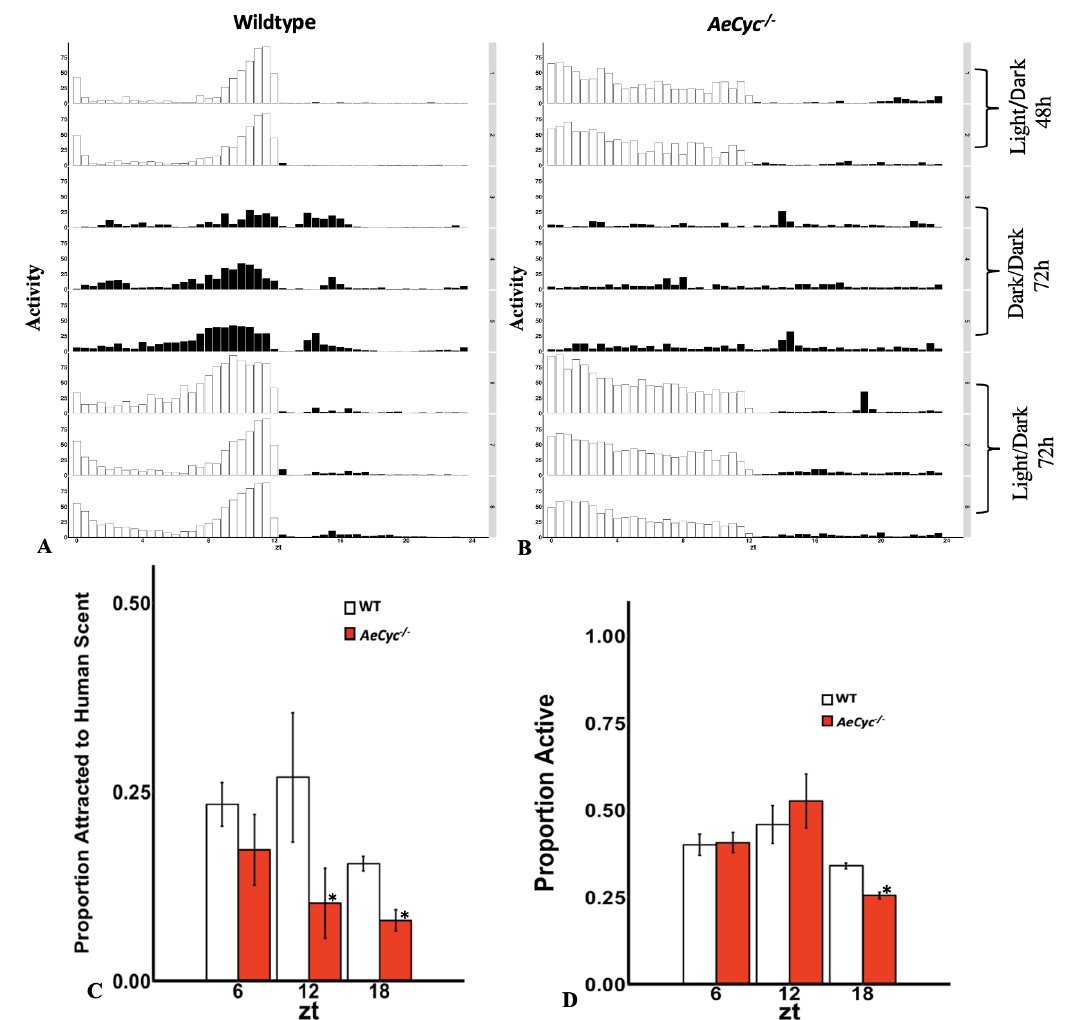
Figure 4. ( A , B ) Circadian activity patterns in wildtype and AeCyc −/− mutants in both both LD and DD conditions. ( C ) Attraction of wildtype and AeCyc −/− females to human odor in olfactometer. Proportion attracted = the proportion of mosquitoes in the arm of the olfactometer that contained the sock. ( D ) Comparing activation of wildtype and AeCyc −/− mutants in olfactometer. “activation” = the proportion of females leaving the release cage of olfactometer. *Statistically significant p ≤ 0.05.